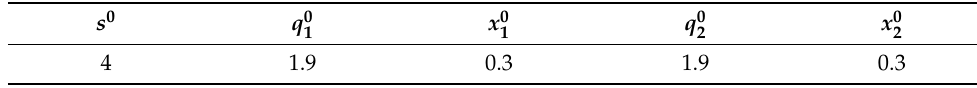
Table 4. The initial conditions used in Example